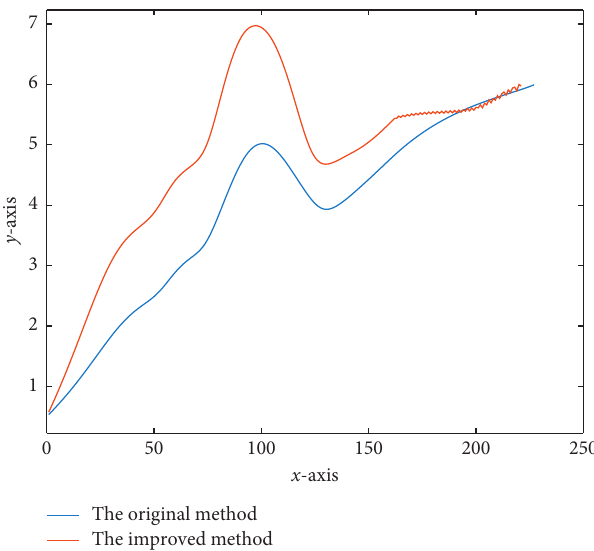
Figure 2: Two height curves of the original algorithm and the improved